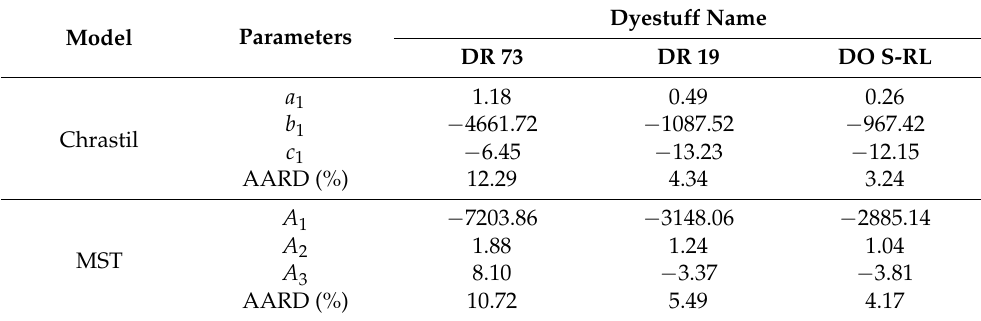
Table 3. Model parameters for DR 73, DR 19 and DO S–RL in Equations (2)–(5) and calculated values of AARD%.